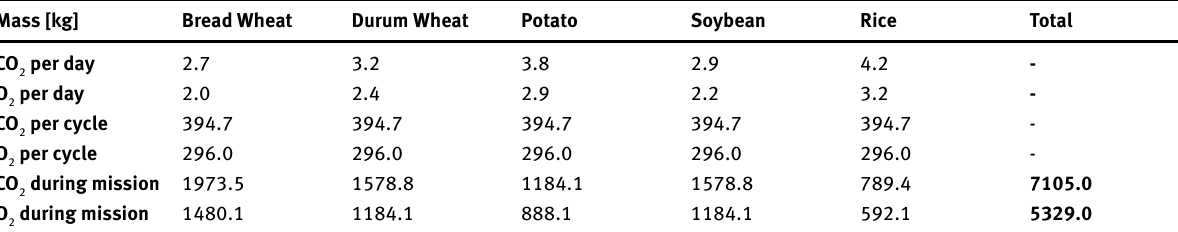
binding and O 2